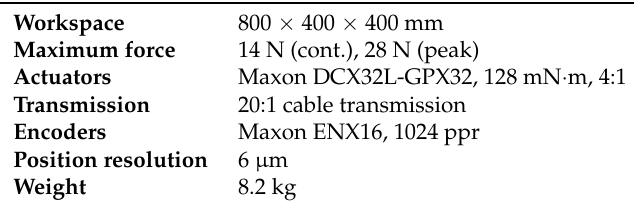
Table 1. HomeRehab specifications.